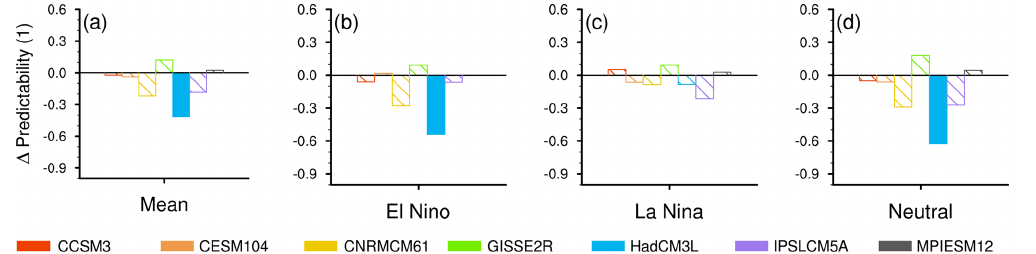
Figure 7. Changes in ENSO predictability in the mean state and in El Niño, La Niña and neutral states. Solid bars represent changes that are significant at the 5% level of a bootstrap test, while hatched bars represent changes that are insignificant.